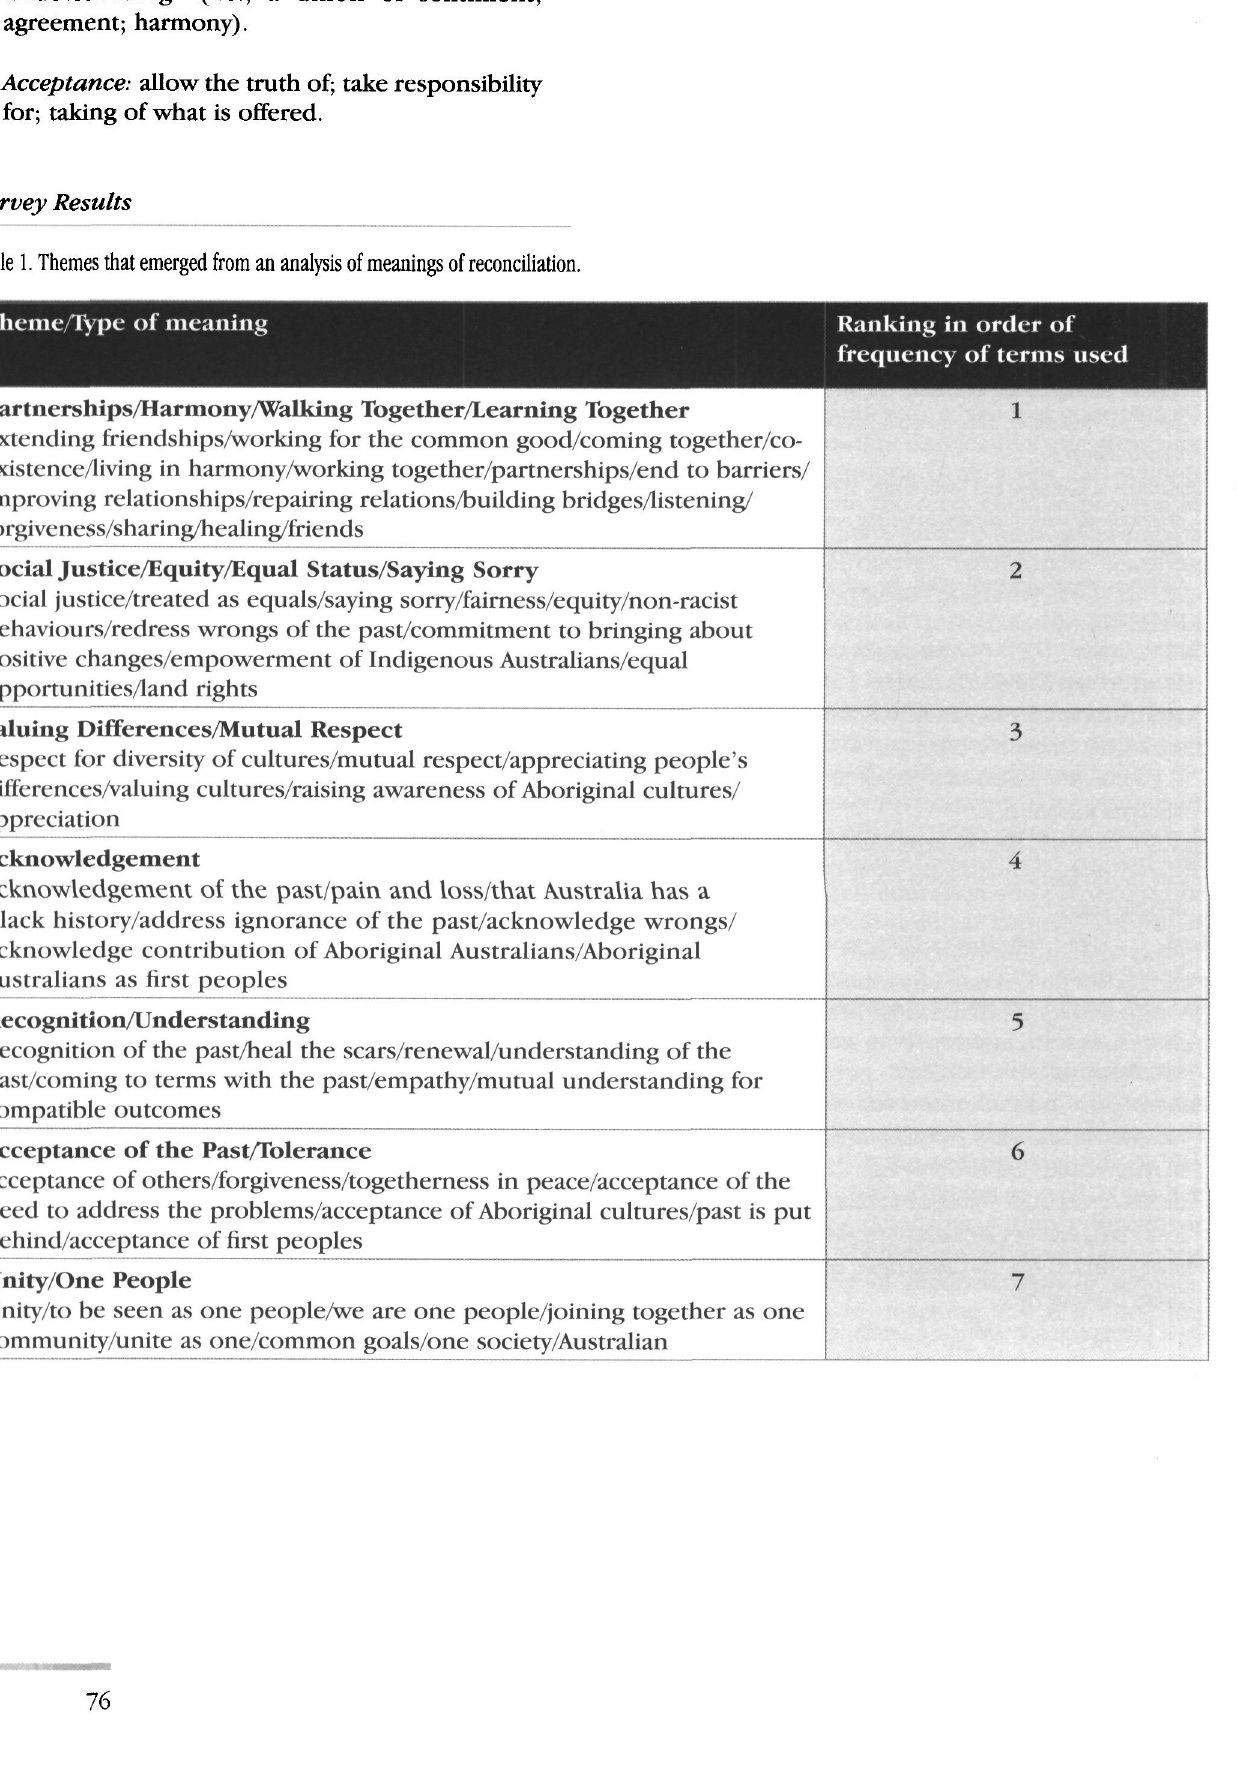
Table 1. Themes that emerged from an analysis of meanings of reconciliation. Theme/Type of meaning Ranking in order of